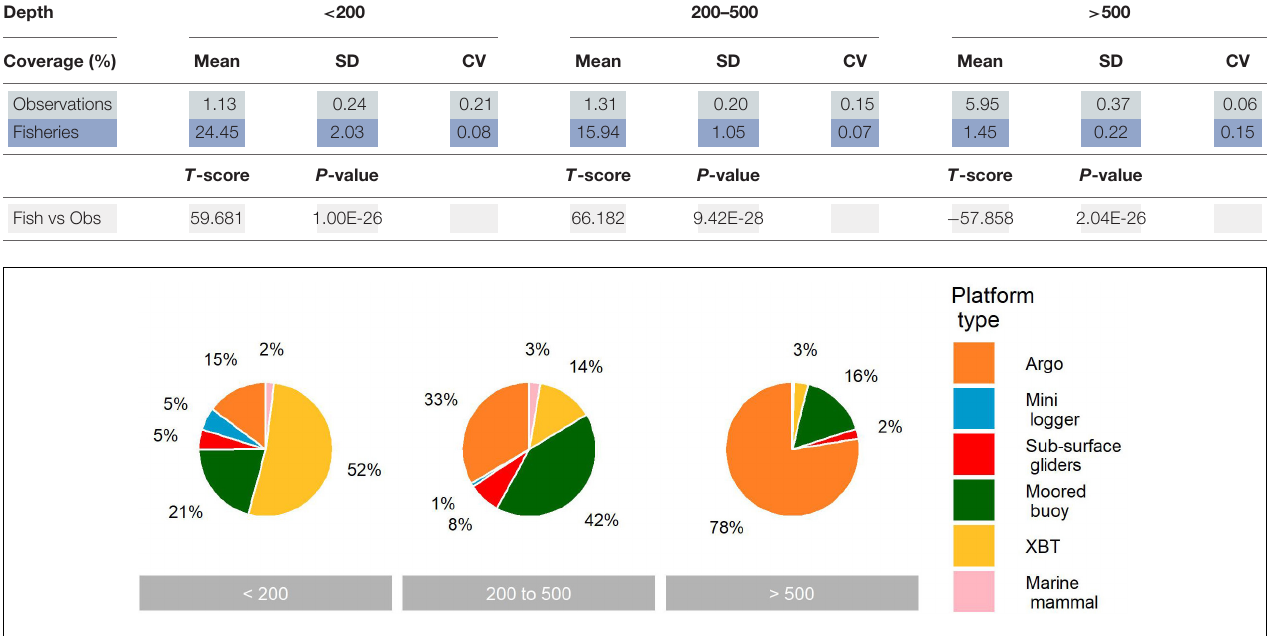
at 1.5% ( Figure 10 , Table 4 ). In the shelf-break and shelf depth classes, fishing mean coverages are lower than New Zealand and the North Atlantic, but higher than Alaska. The differences in mean coverage percentages in all depth classes ( Figure 10 ) are substantial and statistically significant ( Table 4